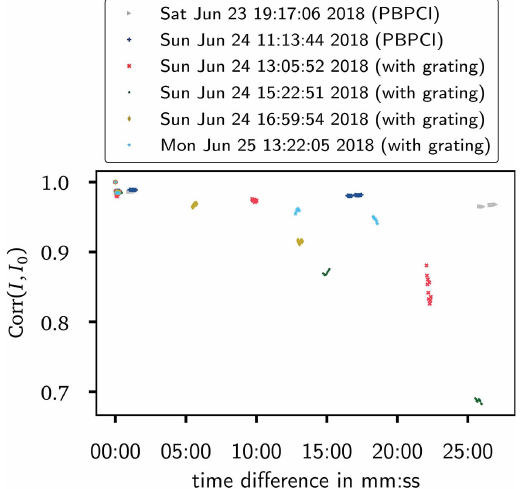
Figure 3 Similarity between different reference frames as assessed by temporal changes in their correlation coefficient. A new starting frame was defined whenever the setup was changed, leading to the depicted grouping. For each group the time stamp of the first acquisition is specified in the legend.